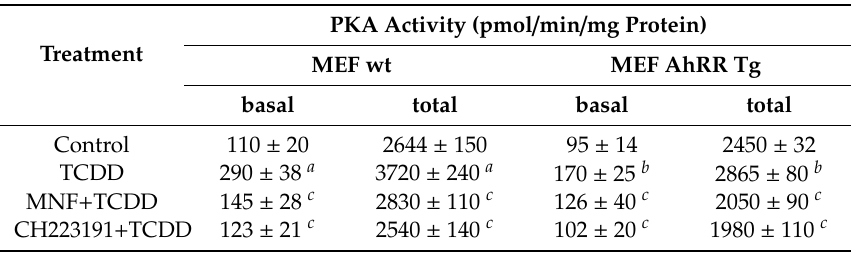
Table 1. E ff ect of AhRR on TCDD-mediated PKA